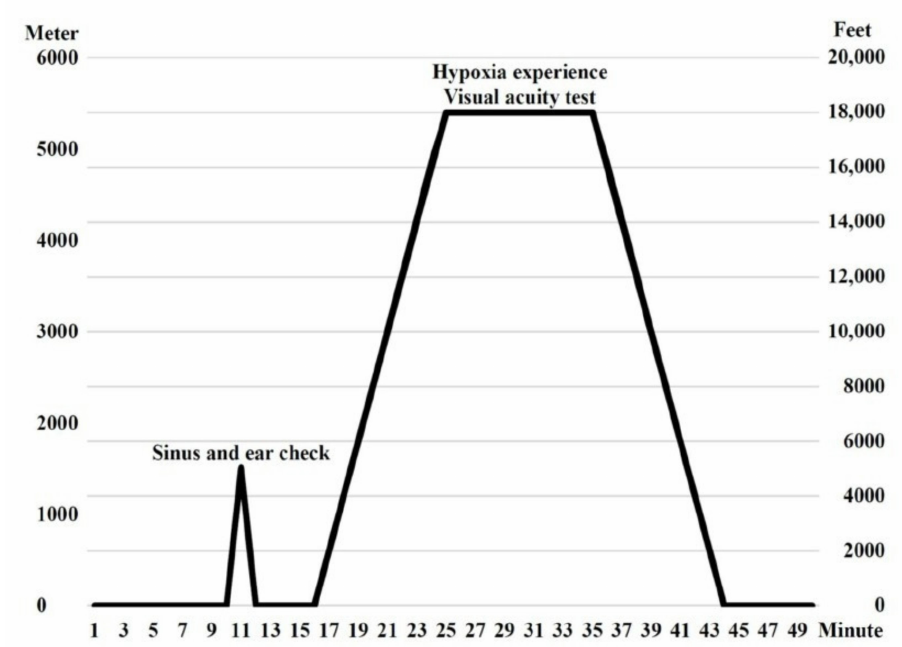
Figure 1. Profile of altitude hypoxia